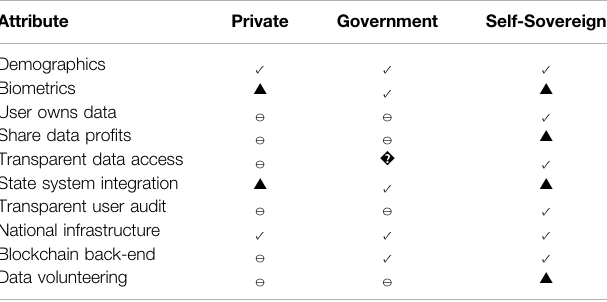
TABLE 1 | Identity Service Comparison